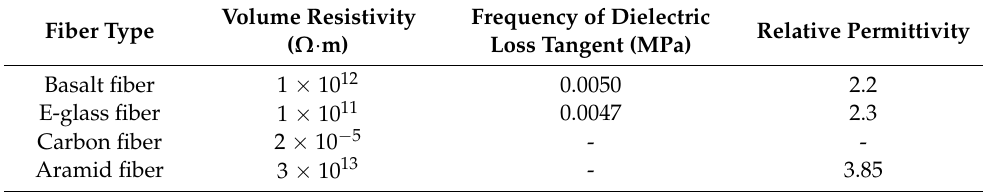
Table 3. Comparison of dielectric properties between BF and other fibers